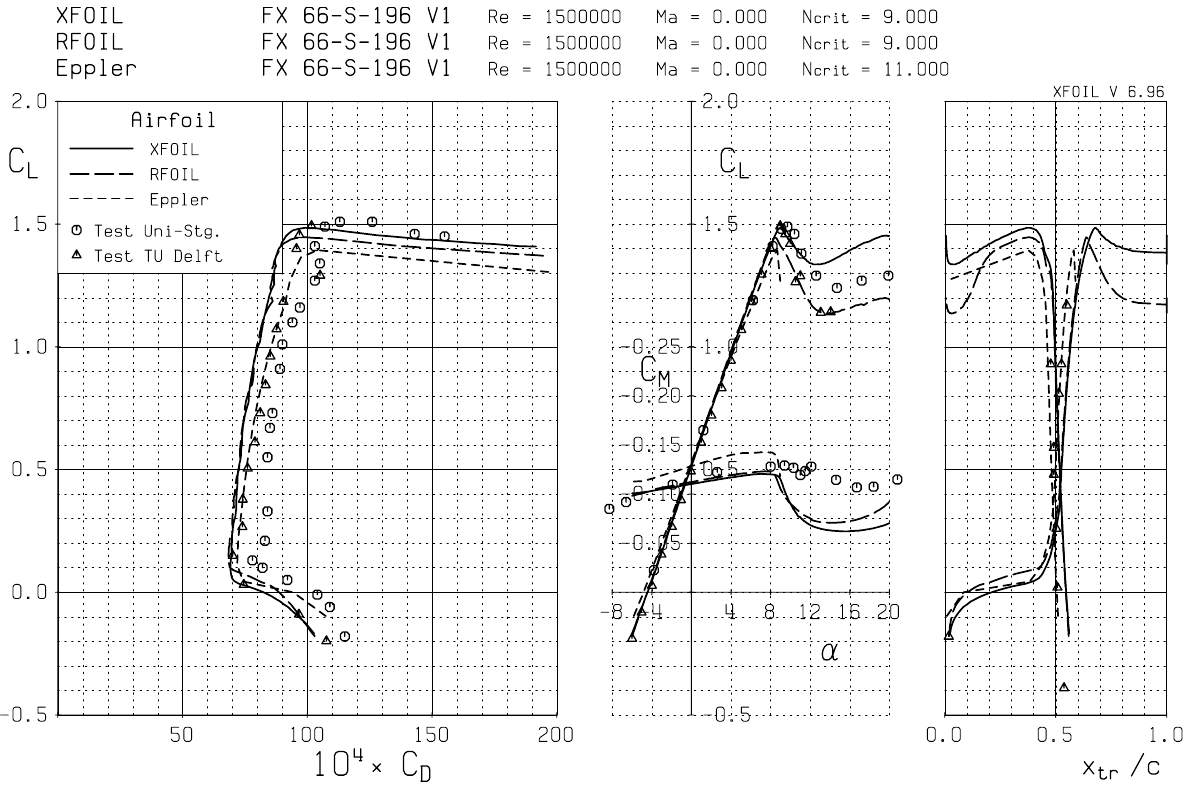
Fig 5. Comparison of calculated and measured data of FX 66-S-196VI airfoil at Re = 1.5·10 6